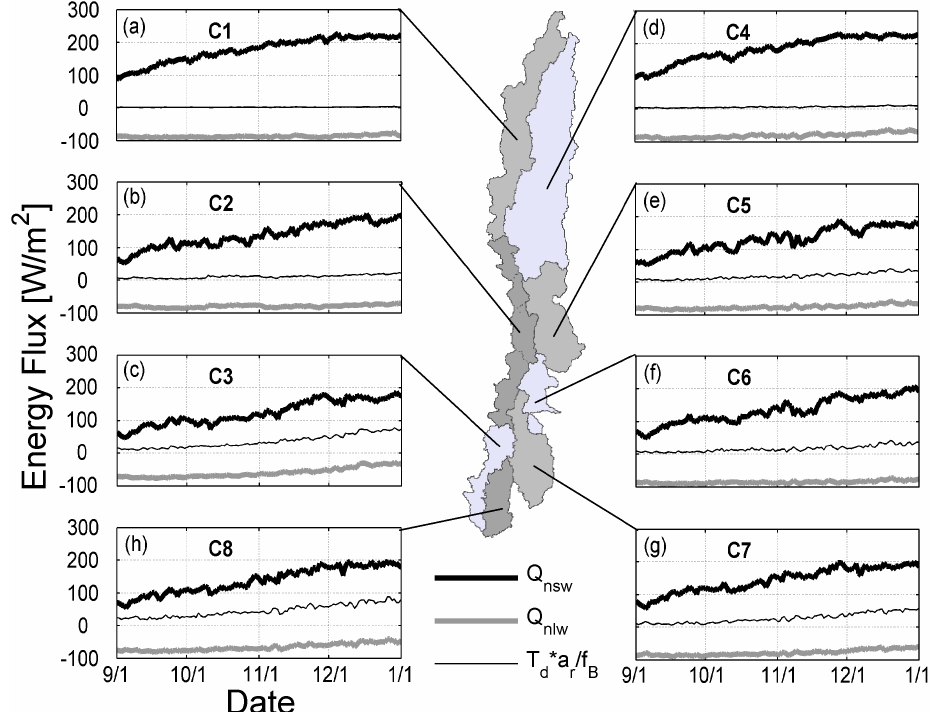
Figure 9. Time series of energy fluxes over snow surface (average over 14 years) and global average per cluster. Unique axes scale for all plots.